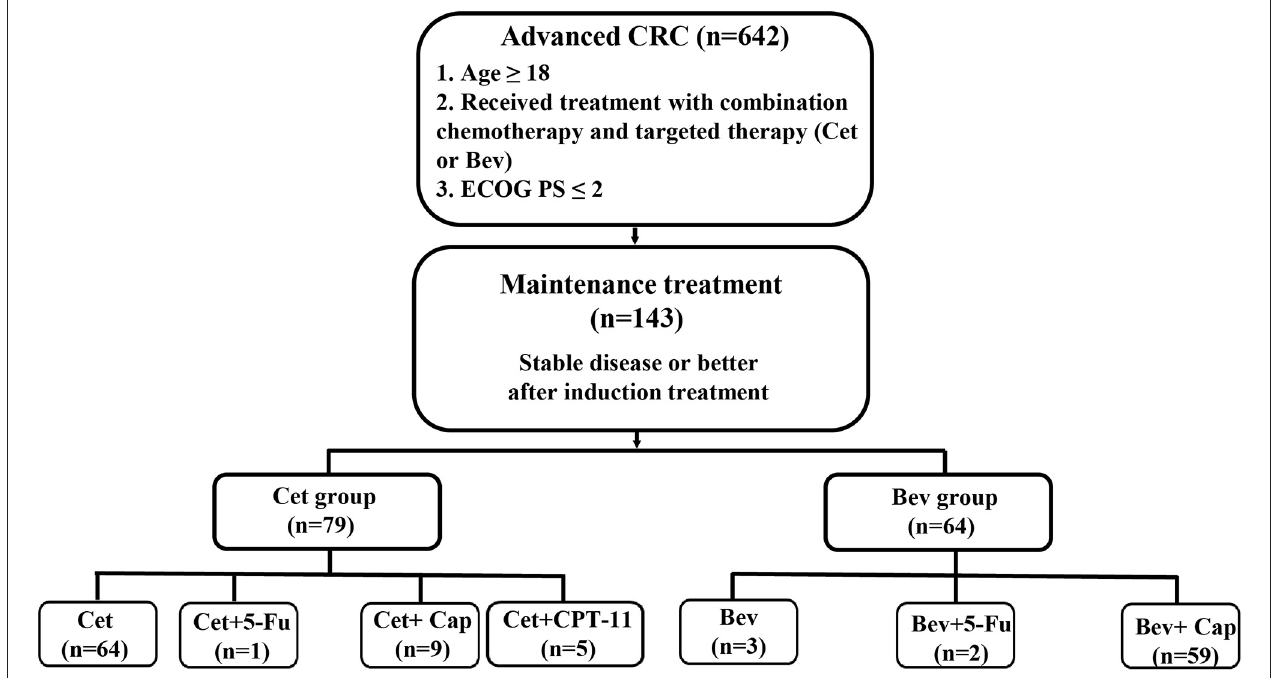
FIGURE 1 | Study design. Cap, Capecitabine; CPT-11, Irinotecan; Fu, fluorouracil.